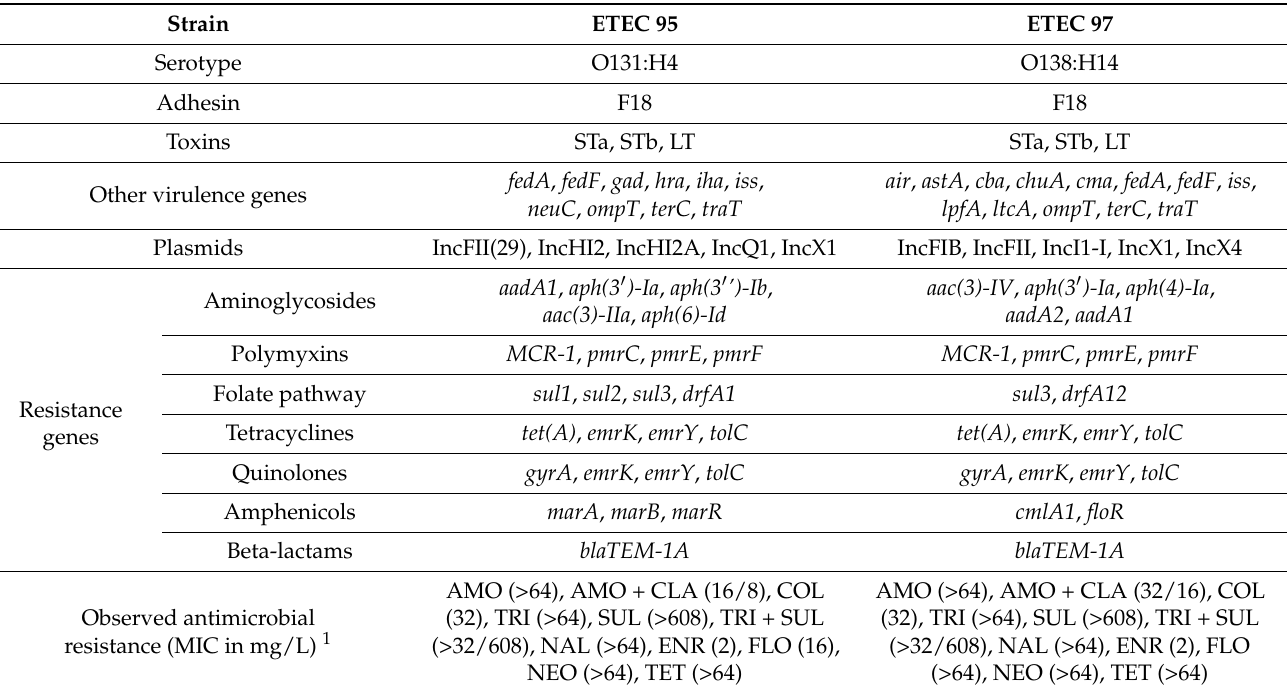
Table 8. Characteristics of ETEC 95 and ETEC 97 strains selected for WGS and gene expression analysis.